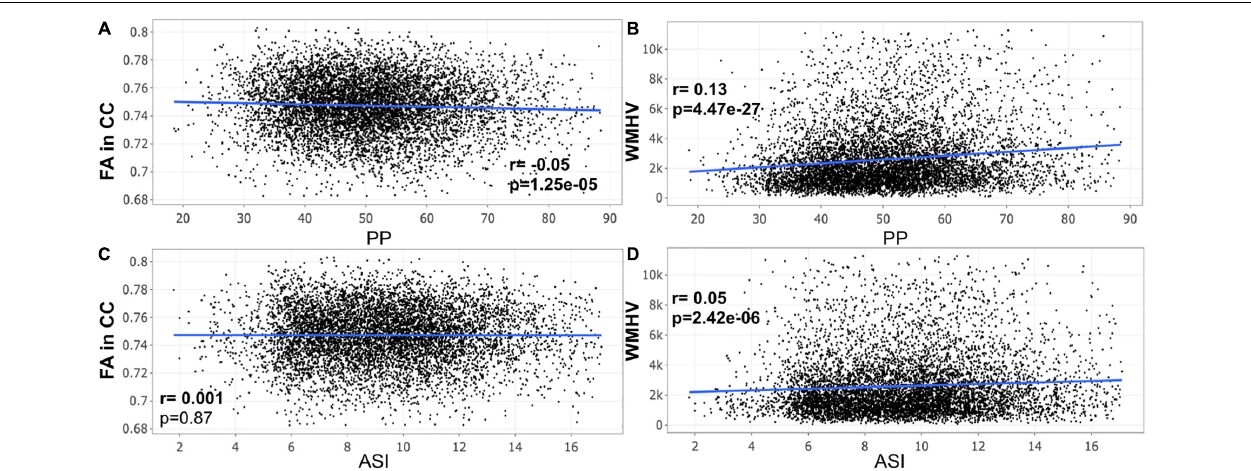
FIGURE 2 | Scatter plot for partial correlation analysis of either pulse pressure (PP) or stiffness Index (ASI) with the fractional anisotropy of the corpus callosum (FA in CC) or the white matter hyperintensity volume (WMHV) in 7,306 participants between 55 and 65 years old. Significant p -values are in bold (adjusted threshold with FDR was 0.0375). Covariates included sex. An additional analysis was performed with both age and sex as covariates showing similar significant results: (A) p = 5.2e-04; (B) p = 7.38e-17; (C) p > 0.0375; (D) , p = 2.75e-05.